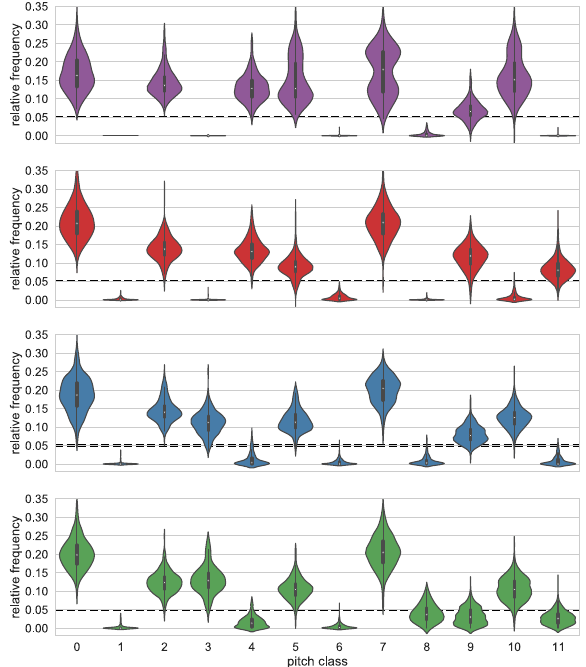
Fig. 7 Violin plot of pitch-class distributions of Renaissance modes. The distribution of the fi rst cluster (violet) resembles the Mixolydian mode, the second cluster (red) resembles the Ionian mode. The two remaining clusters (blue and green) exhibit relatively similar pitch-class distributions that resemble the Dorian mode. The fourth cluster (green) could also be interpreted as